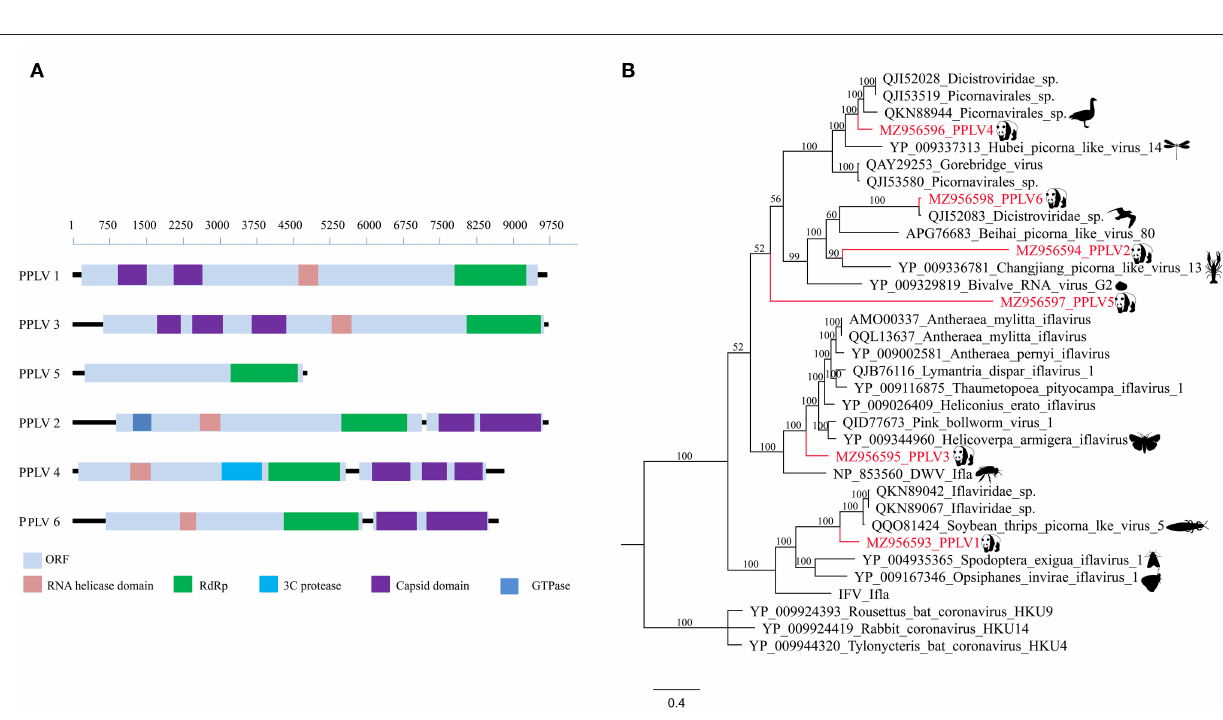
FIGURE 2 | Genomic organization and phylogenetic analysis of the Picornavirales identified in the giant pandas. (A) Genomic organization of six sequences related to order Picornavirales . (B) Phylogenies of viruses belonging to Picornavirales identified in giant pandas. Bayesian inference tree based on amino acid sequences of RdRp of viruses belonging to Picornavirales identified here. Within trees, the viruses found in this study are marked with red line. Each scale bar indicates 0.4 amino acid substitutions per site.